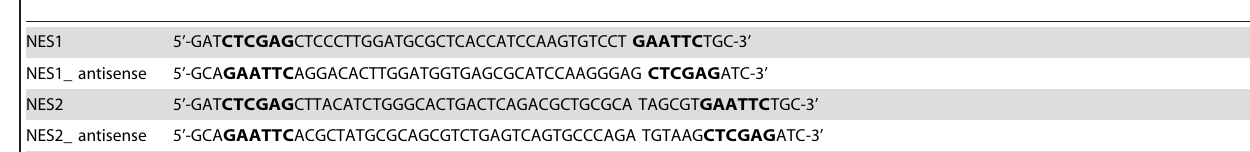
Table 1. Double-stranded oligonucleotides used for the construction of wild-type EGFP-NES1 and EGFP-NES2 constructs.